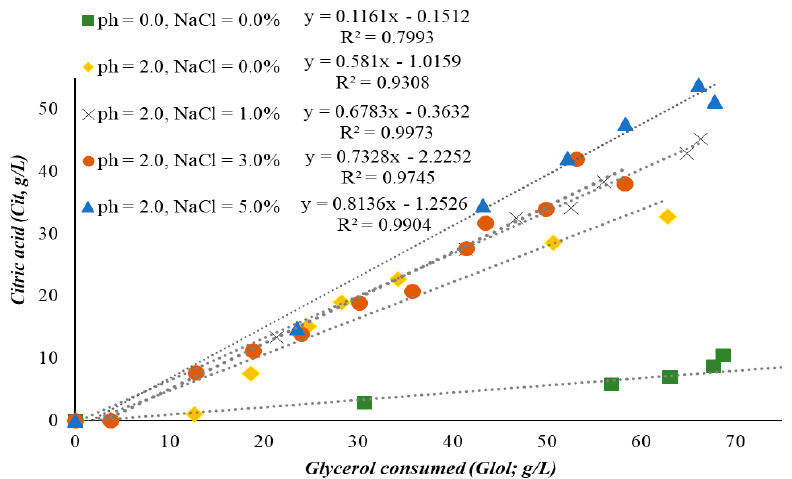
Figure 1. Citric acid production vs glycerol consumption by Yarrowia lipolytica ACA-YC 5031 in 70.0 g/L glycerol (blank) and glycerol blended with 2.0 g/L phenolic compounds and different concentrations of NaCl (0.0%, 1.0%, 3.0%, and 5.0% w/v).